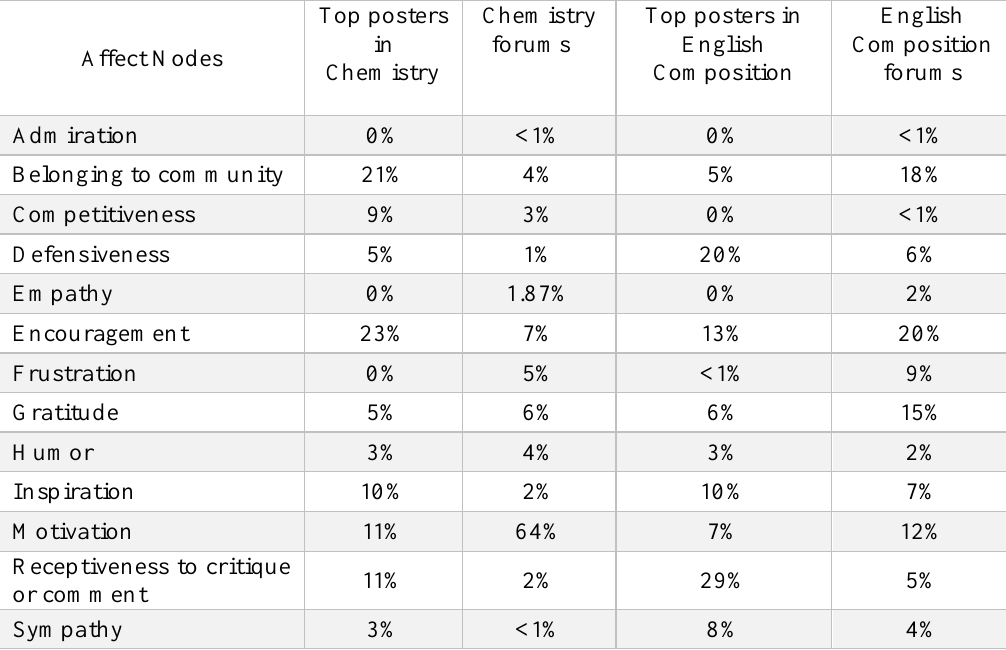
Chemistry forums 13